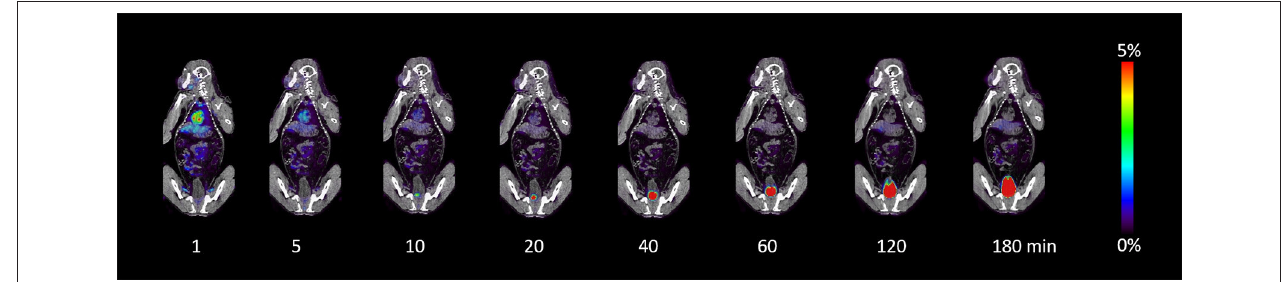
FIGURE 3 | Decay-corrected anterior maximum-intensity projections of PET/CT at 1, 5, 10, 20, 40, 60, 120, and 180min after injection of 64 Cu-BaBaSar-RGD 2 in macaque monkey.